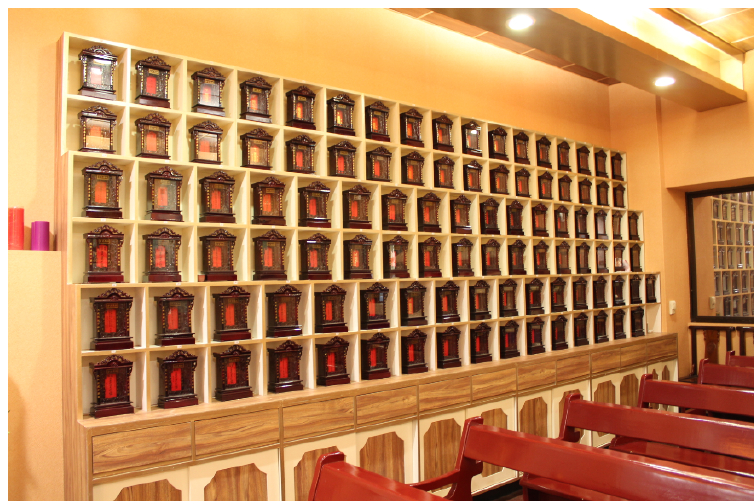
Figure 11. The Ancestors’ Tables in the church of Saint Dominic in